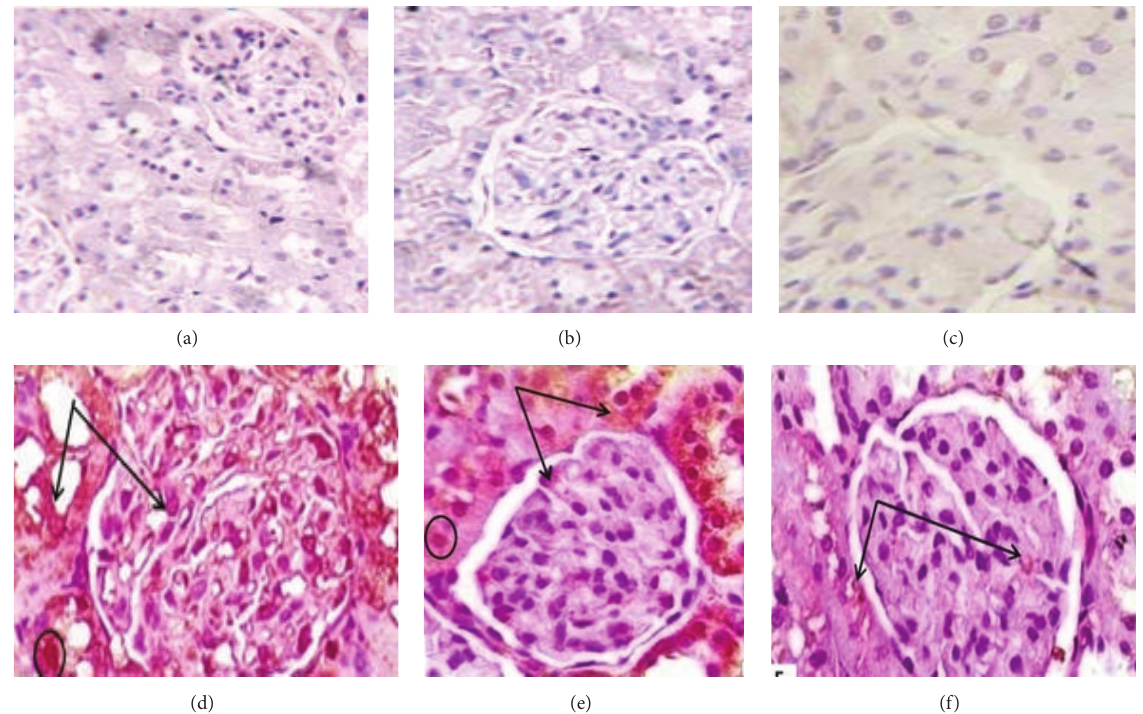
Figure 4: Photomicrographs of renal cortex immune stained for TNF 𝛼 of: (a), (b), and (c), control, DLD, and DHD groups, respectively, showing negative immunoreactivity. (d) DOX treated group showing extensive expression in the renal glomeruli and renal tubules. (e) DOX/DLD group showing moderate expression within the glomeruli and the renal tubules. (f) DOX/DHD group showed marked improvement with no expression in glomeruli and renal tubules. The expression is mainly cytoplasmic, but with some immunopositive nuclei. Immunohistochemistry counter stained with H&E × 400. Bar = 20 𝜇